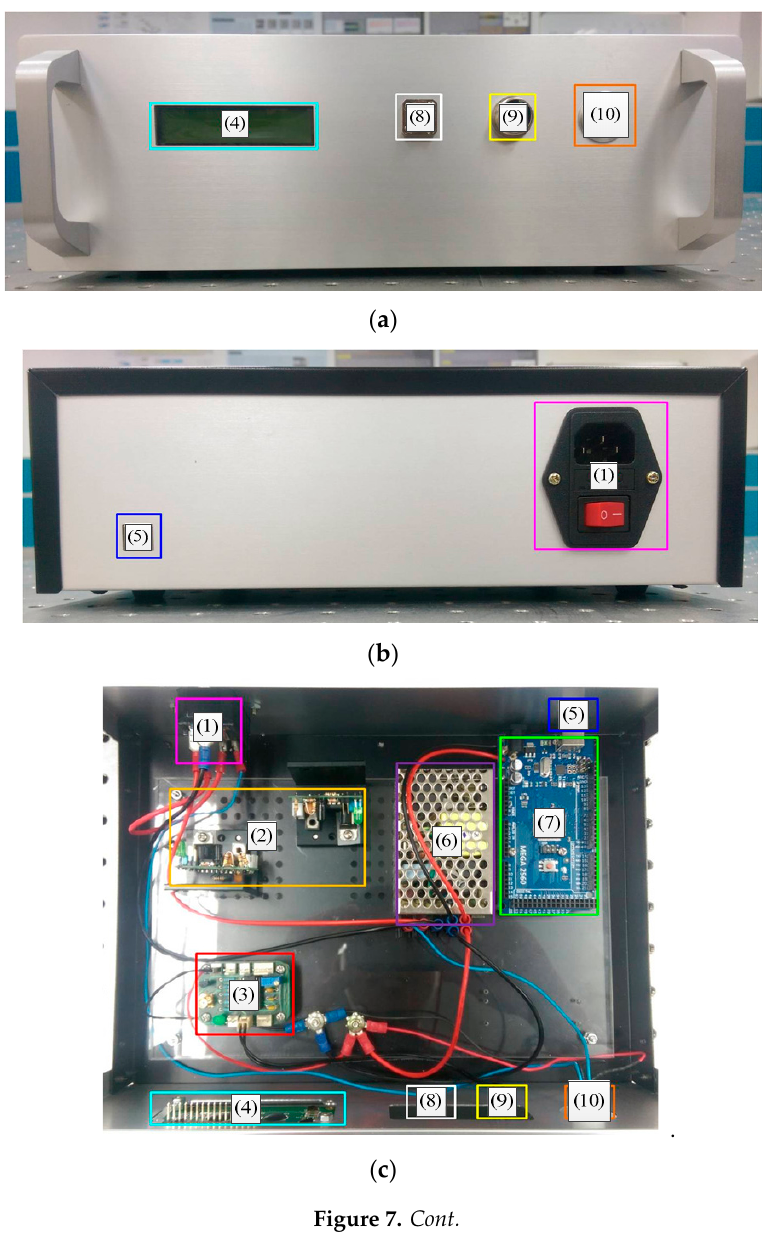
Figure 6. Schematic diagrams of spectrum shift monitoring on two wavelengths: ( a ) initial state; ( b ) right shift within feasible detecting range; ( c ) when the spectrum shift has reached its